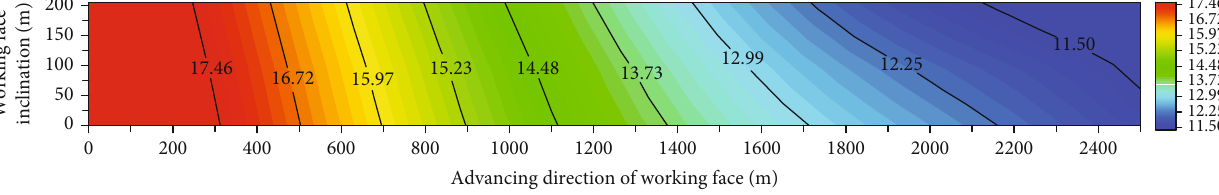
Figure 10: The distance between the top of the water-conducting fractured zone and the fl oor of the Zhiluo group. Table 2: Proportion of mine water sourced from the surrounding operating coal